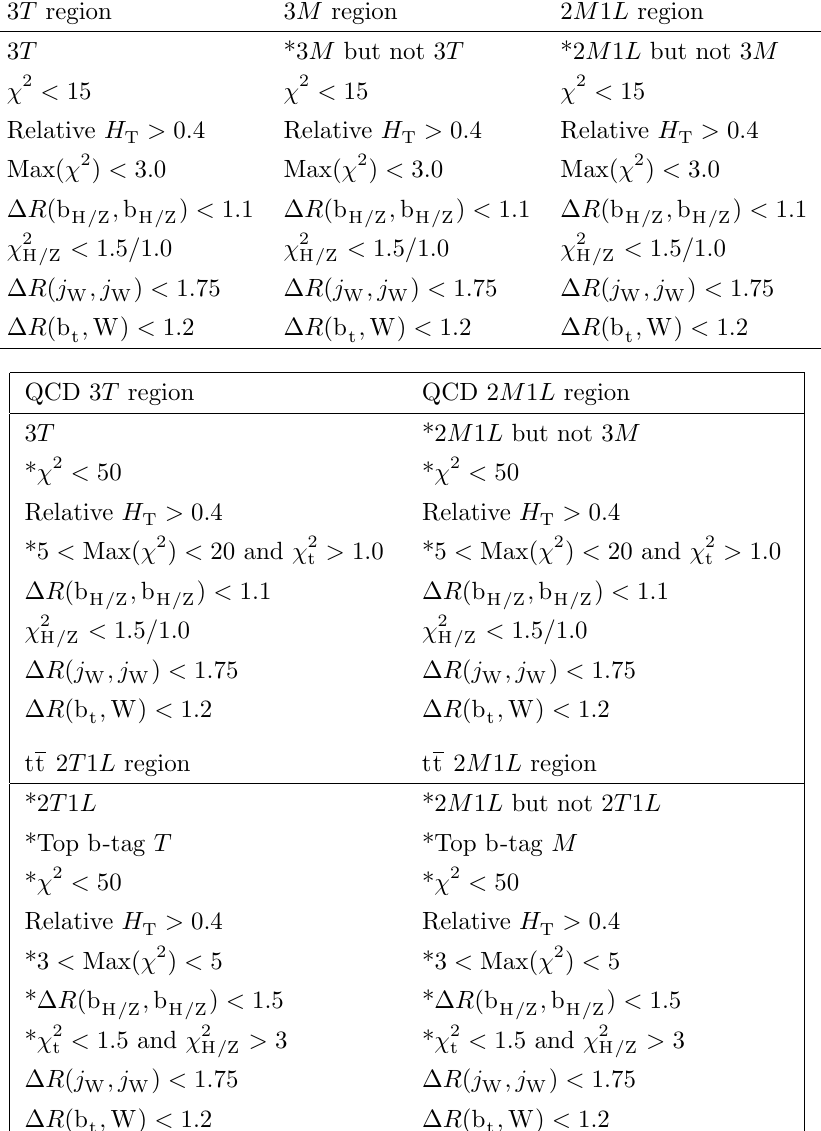
> 100 GeV) and Z channels ( m < 100 GeV). bb bb